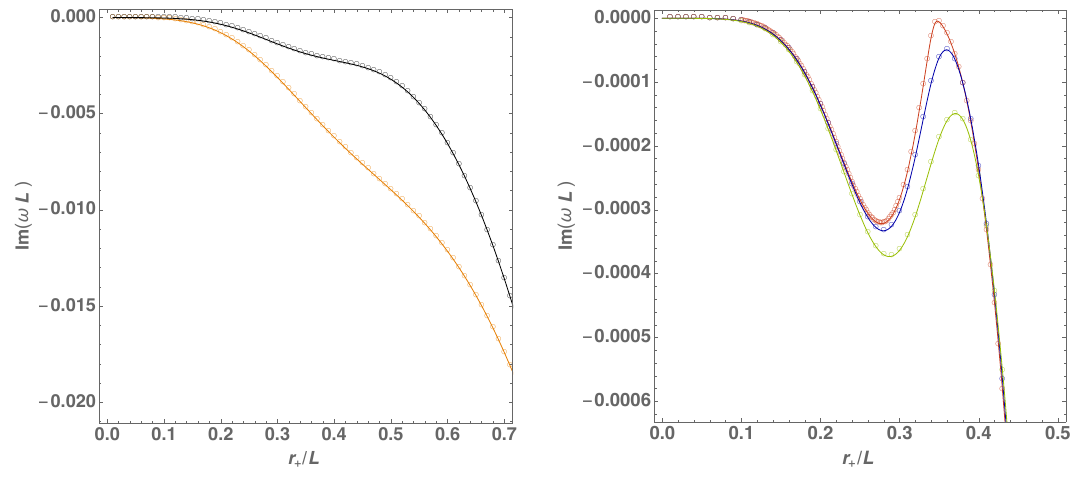
Figure 8 . Imaginary part of the frequency as a function of the horizon radius for fermion (cid:12)eld charge qL = 1 and di(cid:11)erent values of the chemical potential. In the left panel the chemical potentials are (from bottom to top) (cid:22) = 0 : 9 (cid:22) ext (orange) and (cid:22) = 0 : 95 (cid:22) ext (black). In the right panel the chemical potentials are closer to extremality, namely (from bottom to top curves): (cid:22) = 0 : 99 (cid:22) ext (green), (cid:22) = 0 : 995 (cid:22) ext (blue) and (cid:22) = 0 : 999 (cid:22) ext (red). Notice the di(cid:11)erent regions scanned by the axes in the two